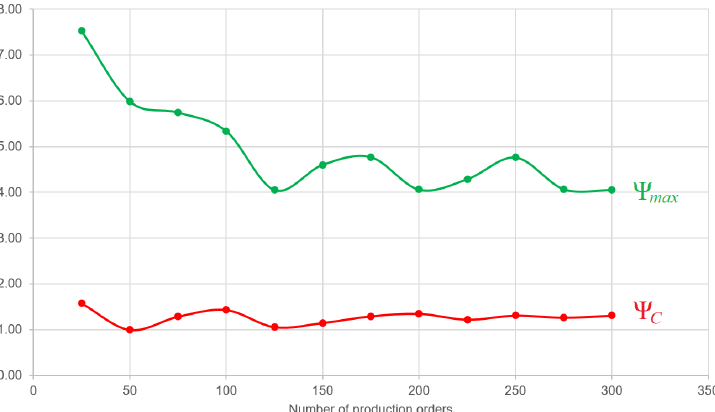
Figure 9. The effect of taking into account the influence of resources for the production of the closing